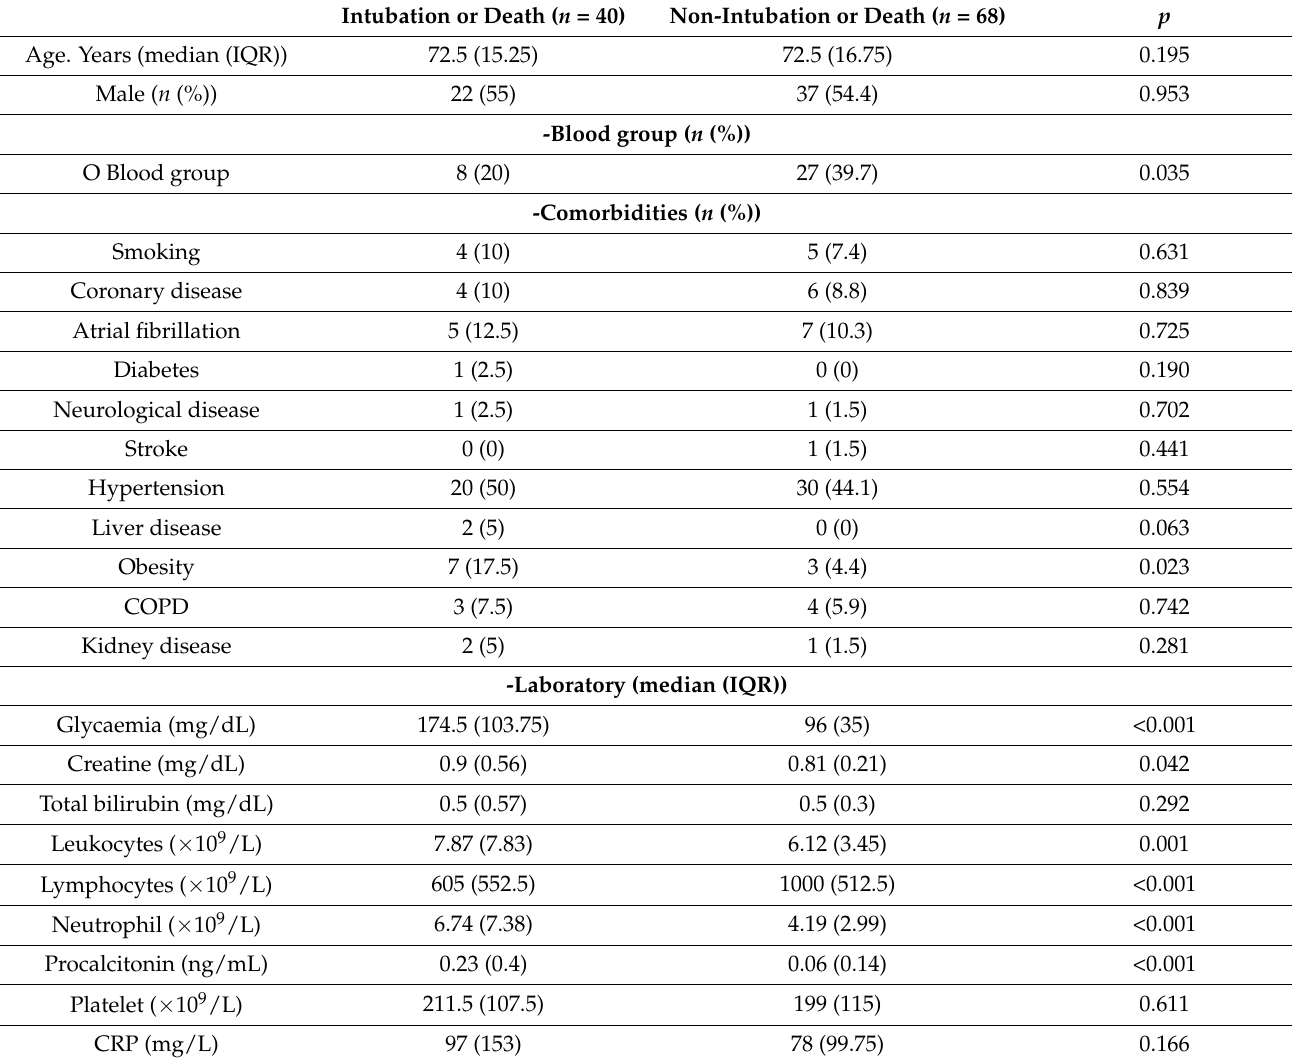
Table 1. Clinical characteristics of the patients according to Intubation or death